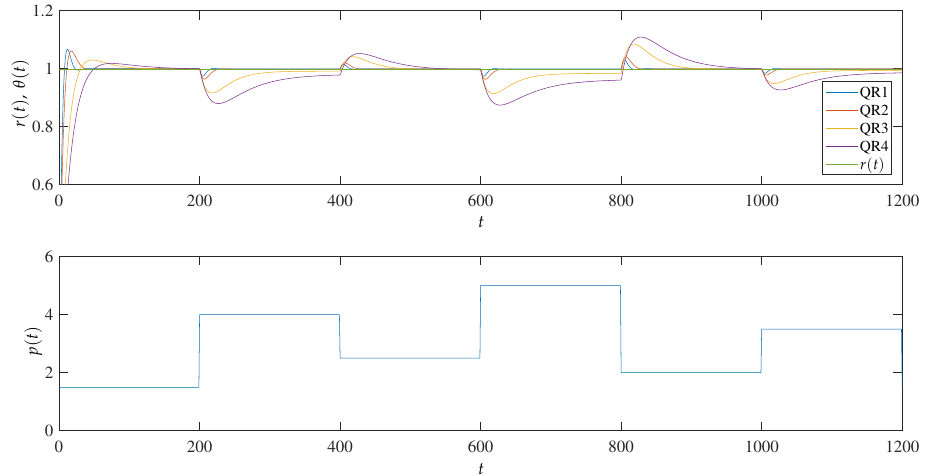
Figure 20. Response of the system for different disturbance